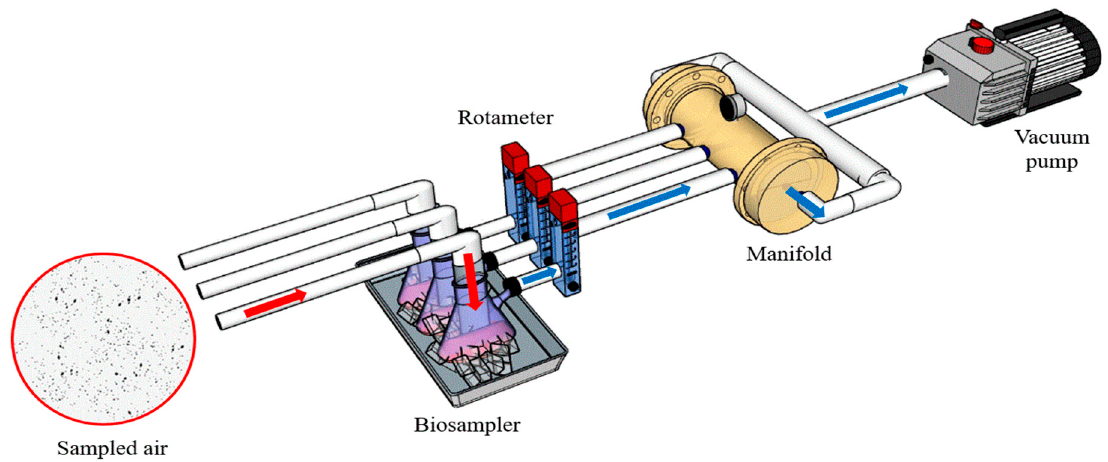
Figure 2. Schematic of an airborne pathogen sampling system. Red arrow: Sampled air with the viable and non-viable particulate matter emitted from the swine barn ventilation fan and trapped in biosample impingers; Blue arrow: Vacuum-induced airflow. Table 4. CFU removal performance of UV-A photocatalysis (Treatment II) in mitigating airborne pathogens. Comparison of CFU before and after UV-A photocatalysis and resulting percent